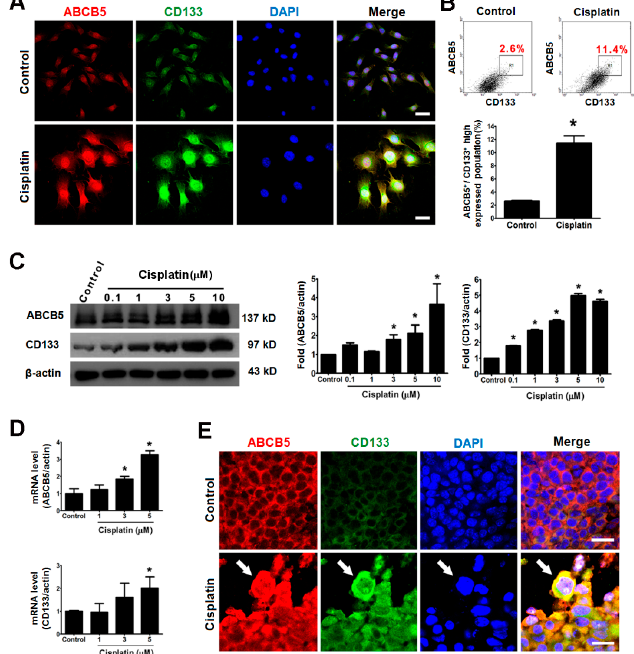
Figure 4. The expressions of ABCB5 and CD133 were elevated in the cisplatin-induced giant cells in vitro and in vivo . The in vitro evidence was obtained from B16-F10 cells that were treated with cisplatin (3 μ M) for 48 h. ( A ) The immunofluorescence of ABCB5 (red) and CD133 (green) in the control B16-F10 cells (top panel) and the cisplatin-induced giant cells (bottom panel). The nuclei were stained with DAPI (blue), and the ABCB5 and CD133 signals that were merged (yellow) to indicate the co-expression of ABCB5 and CD133. Scale bar, 50 μ m. ( B ) The expression of ABCB5 and CD133 were quantified by flow cytometry, and the population overexpressed both ABCB5 and CD133 was gated and shown in the dot plot, and statistical bar chart (bottom panel). The percentages of ABCB5 + /CD133 + high expressed population indicated on the panel are the means of three independent experiments. ( C ) The translational levels of ABCB5 and CD133 were analyzed by Western blot by antibodies specific for ABCB5, CD133, and β -actin. The histograms show the proteins levels quantified by the ABCB5/ β -actin and CD133/ β -actin immunoband intensities. ( D ) The transcriptional levels of ABCB5 and CD133 were measured by qRT-PCR. ( E ) Images of immunofluorescence show that the giant cells overexpress ABCB5 (red) and CD133 (green) in tissue specimens from mice. The nuclei were stained with DAPI (blue), and the ABCB5 and CD133 signals were merged (yellow), and the white arrows indicate the giant cell with highly expressing ABCB5 and CD133. Scale bar, 20 μ m. * p < 0.05 compared with the control group.